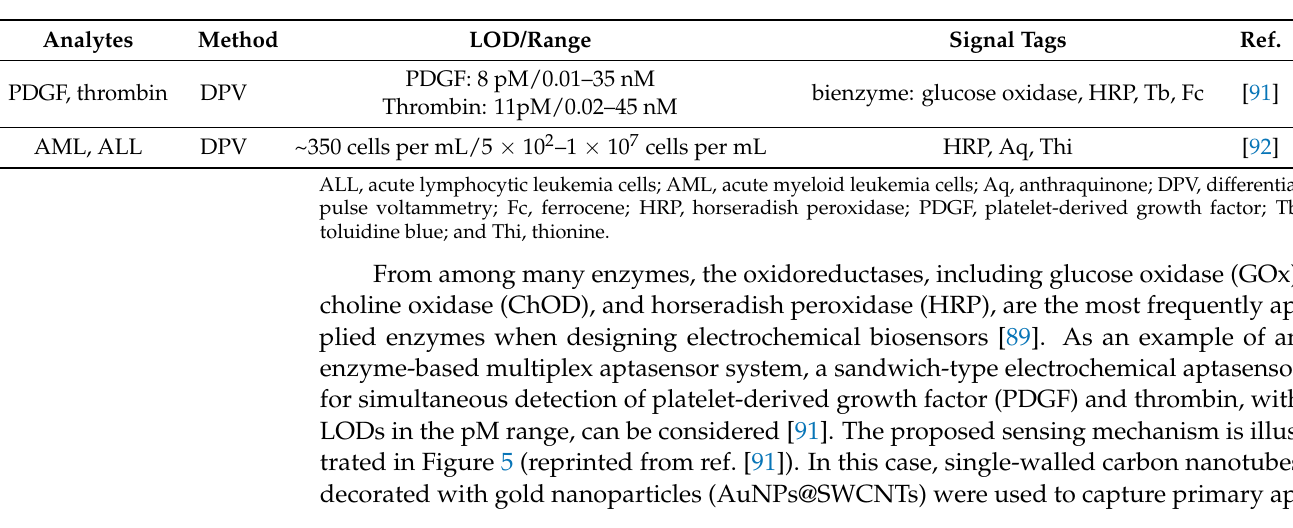
Table 3. Multiplex electrochemical aptasensors based on enzymatic